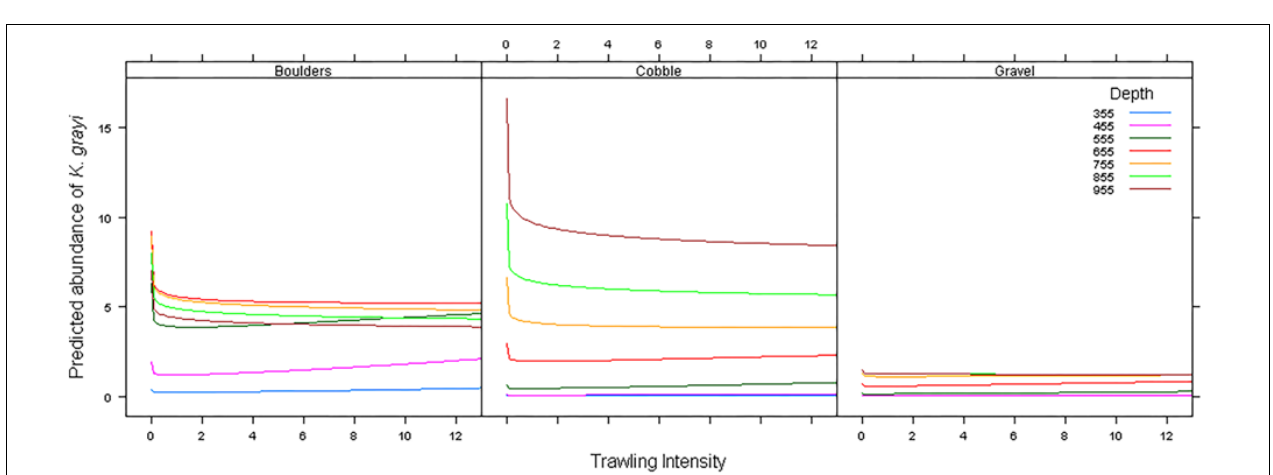
FIGURE 2 | Model predictions of the influence of trawl intensity on the probability of Keratoisis grayi presence in boulders (solid), cobble (dotted), and gravel (dashed) within each canyon. Depth was held constant at the mean depth in each canyon in all models.